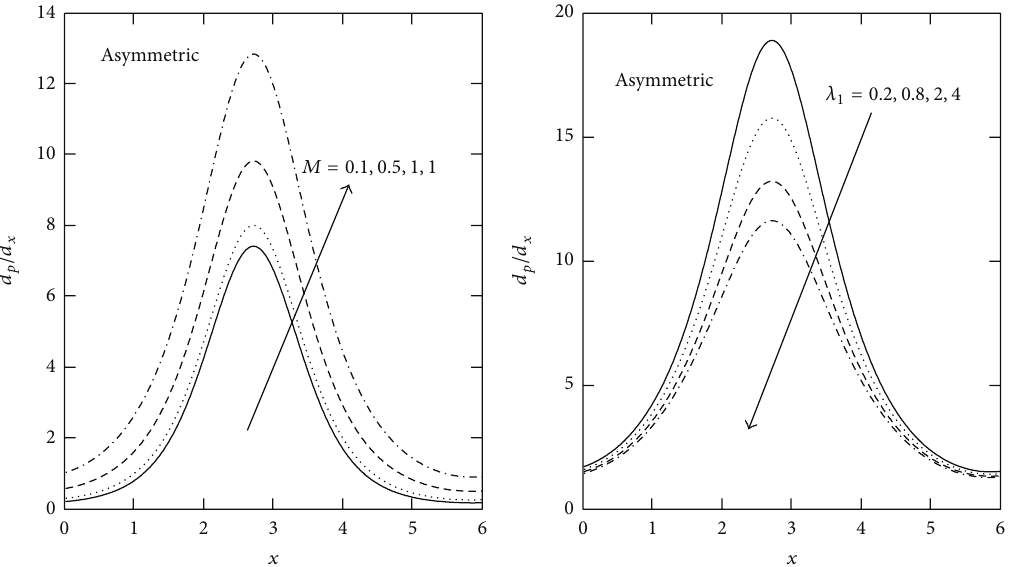
Figure 1: Variation of 𝑑𝑝/𝑑𝑥 with influence of 𝑀 and 𝜆 1 respect to 𝑥 .